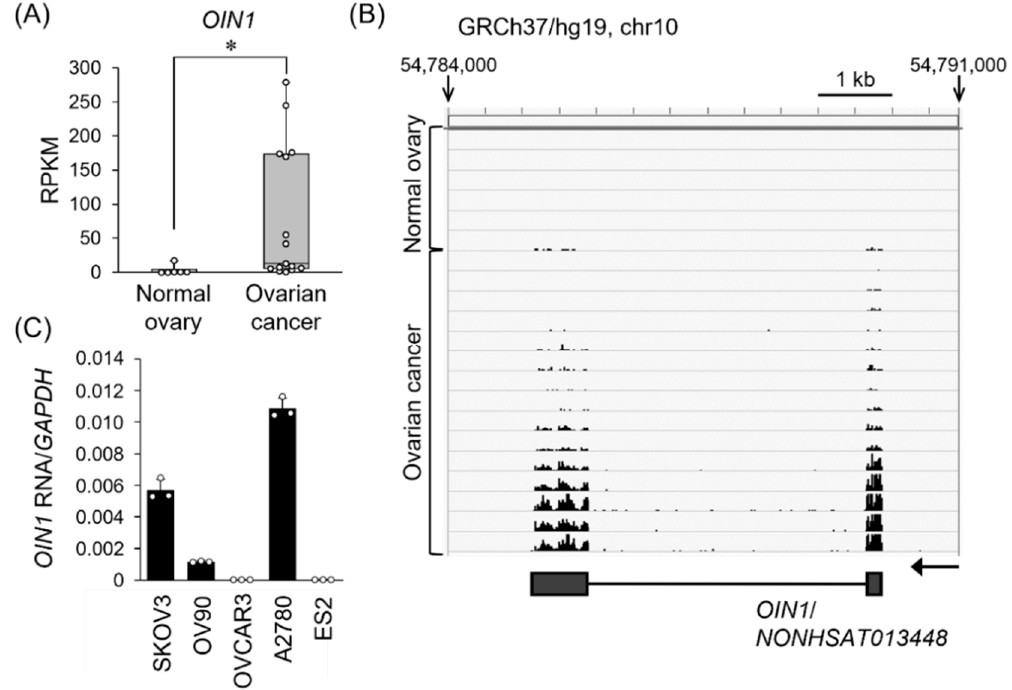
Figure 1. Overexpression of lincRNA OIN1 in ovarian cancer. ( A ) OIN1 RNA (registered as NONHSAT013448 in NONCODE) is overexpressed in ovarian cancer. RPKM (reads per kilobase of transcript length per million mapped reads) values of OIN1 RNA were estimated by RNA-seq analysis using ovarian cancer ( n = 15) and normal tissues ( n = 6) [15,16]. Data are presented by box plots. * , q < 0.01. ( B ) The mapping data of RNA-seq reads derived from normal ovary tissues and ovarian cancer on the OIN1 locus. A genome browser snapshot of the OIN1 region (chr10:54,784,000–54,791,000 in hg19) was shown with the schematic representation of OIN1 gene. The grey boxes indicated the exons of OIN1 . The arrow shows the direction of OIN1 gene. ( C ) OIN1 RNA expression levels in ovarian cancer cell lines. qRT-PCR was performed to quantify the expression levels of OIN1 RNA normalized to GAPDH mRNA levels. Data are presented as mean ± SD ( n = 3).